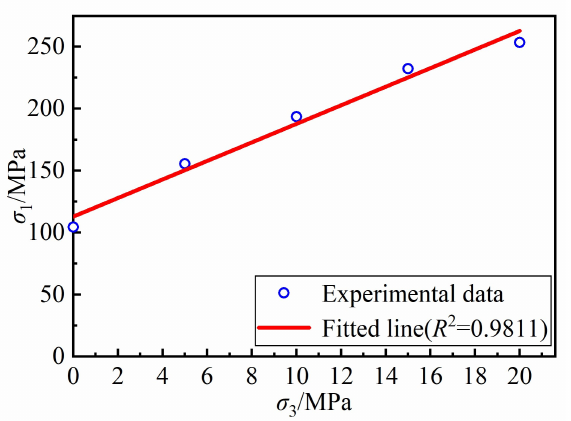
Figure 13. Relationship between σ 1 and σ 3 of deep-metamorphic limestone.